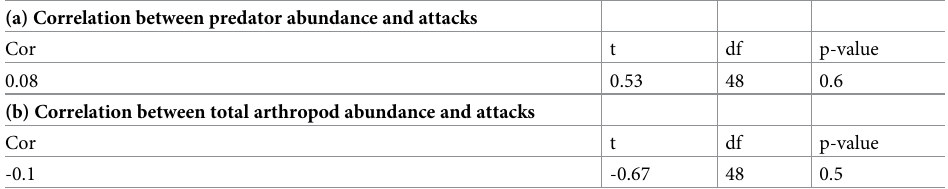
Table 4. Summary table for a Pearson correlation test between the number of attacked plasticine larvae and (a) predator abundance and (b) total arthropod abundance caught in the pitfall